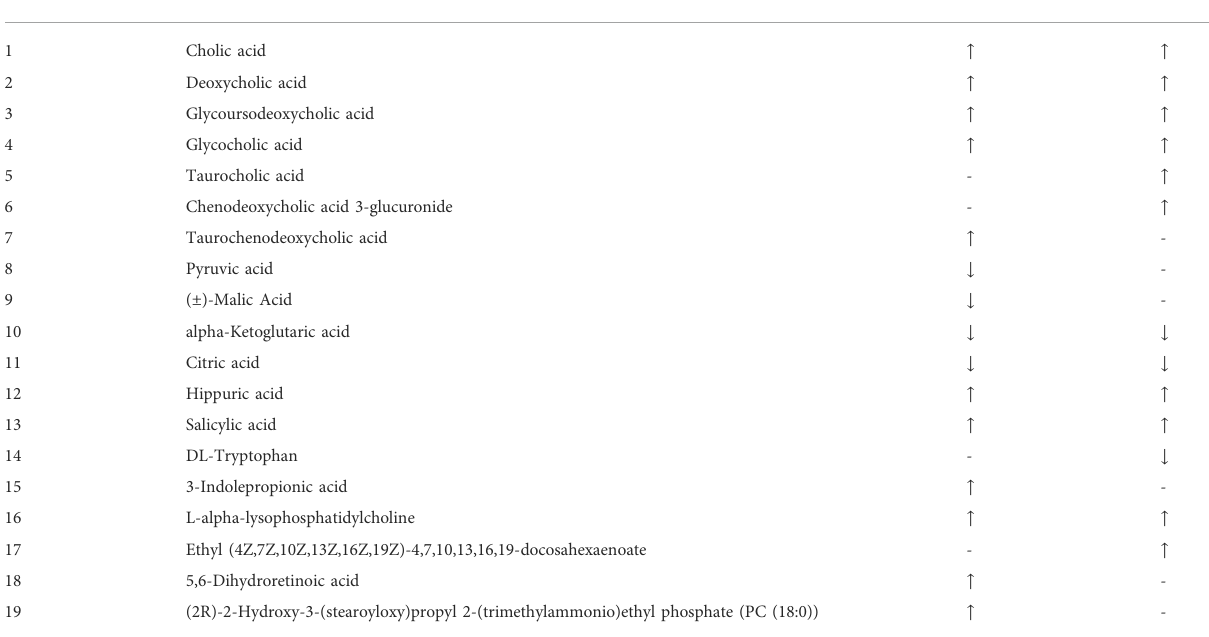
TABLE 1 Differential metabolites with dose-time-effect induced by STRER.